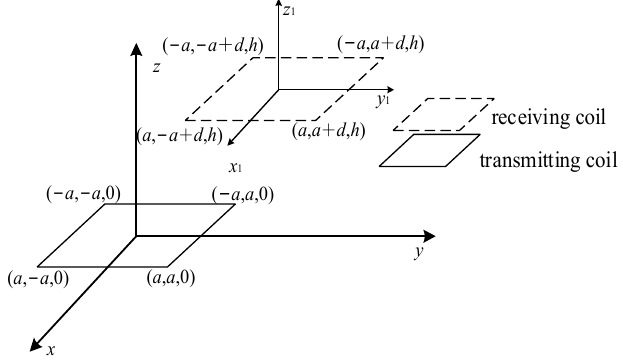
Figure 3. Relative Position Diagram of Transceiver Coil.